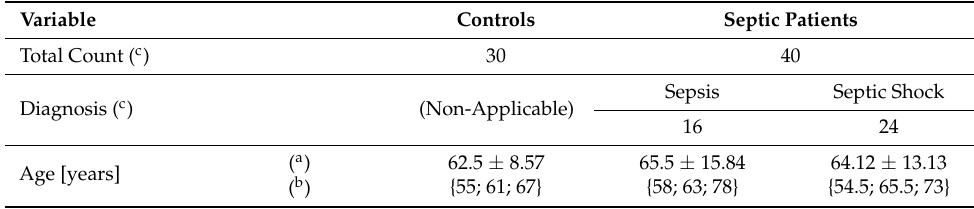
Table 1. Clinical and demographic data describing the studied population